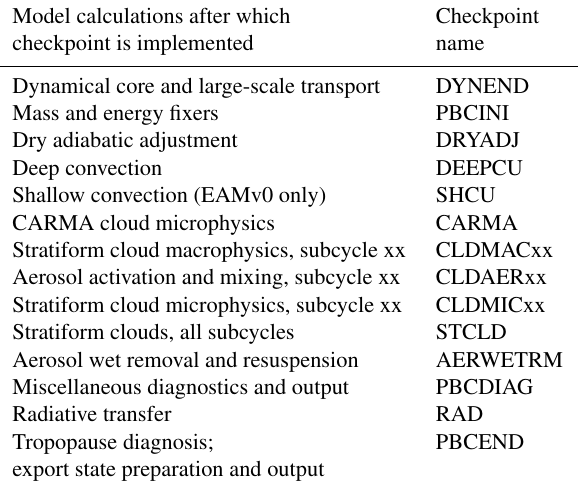
Table B1. Checkpoints in the parameterization suite calculated be- fore coupling with surface models, i.e., in the tphysbc subroutine. The order of checkpoints in the table is the same as the actual order of the checkpoints in the code.